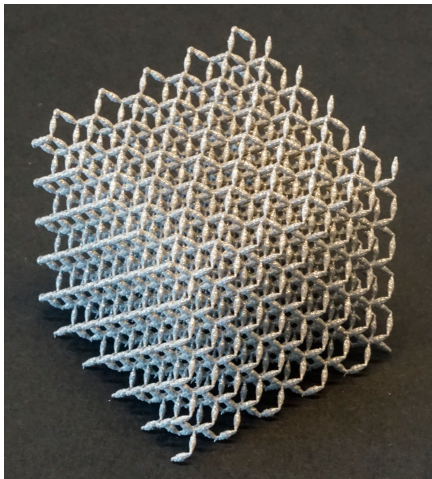
Figure 3. A penta-mode mechanical metamaterial made with selective laser melting at Additive Manufacturing Lab, TU Delft (Researchers: Reza Hedayati and Sander Leeflang) (specimen dimensions: 4 cm × 4 cm × 4 cm). The special geometry of the struts in this type of mechanical metamaterials results in some kind of fluid-like behavior. Moreover, the usual power-law relationship between the relative density and mechanical properties (Ashby’s laws) break down. For more details, see [69].